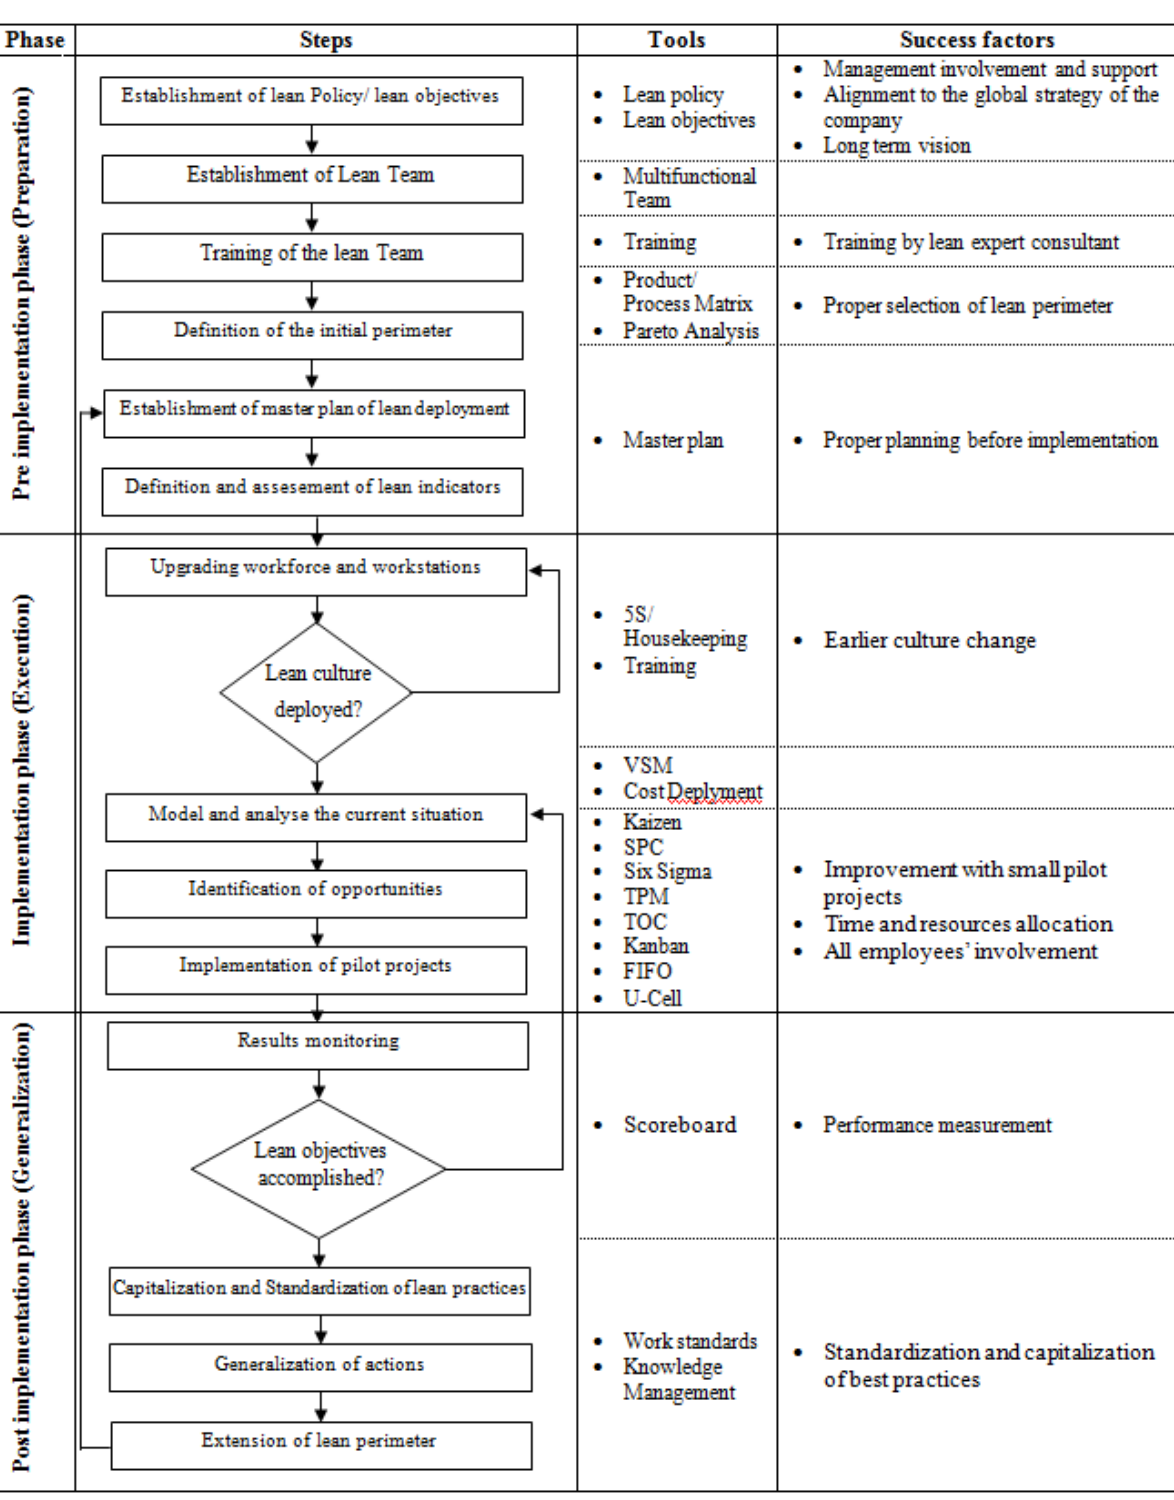
Figure 3. Proposed lean implementation framework in